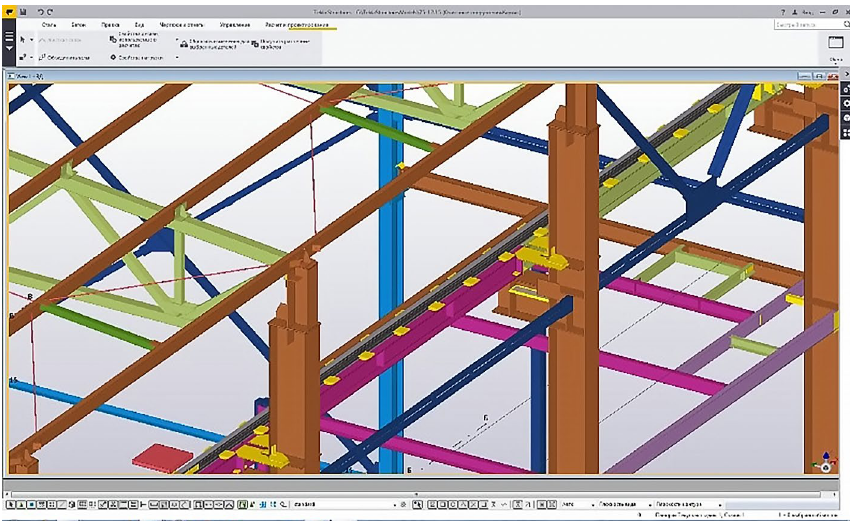
Figure 6. A fragment of the physical model for the structure applying Tekla Structures